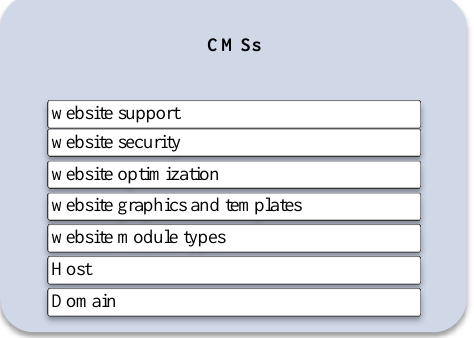
Figure 1. Factors affecting final cost of